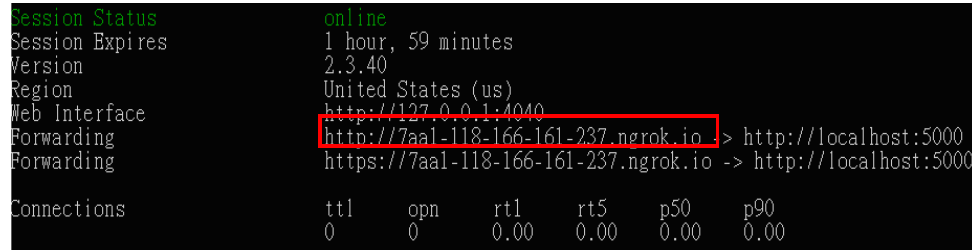
Figure 10. The startup screen of the web proxy service.